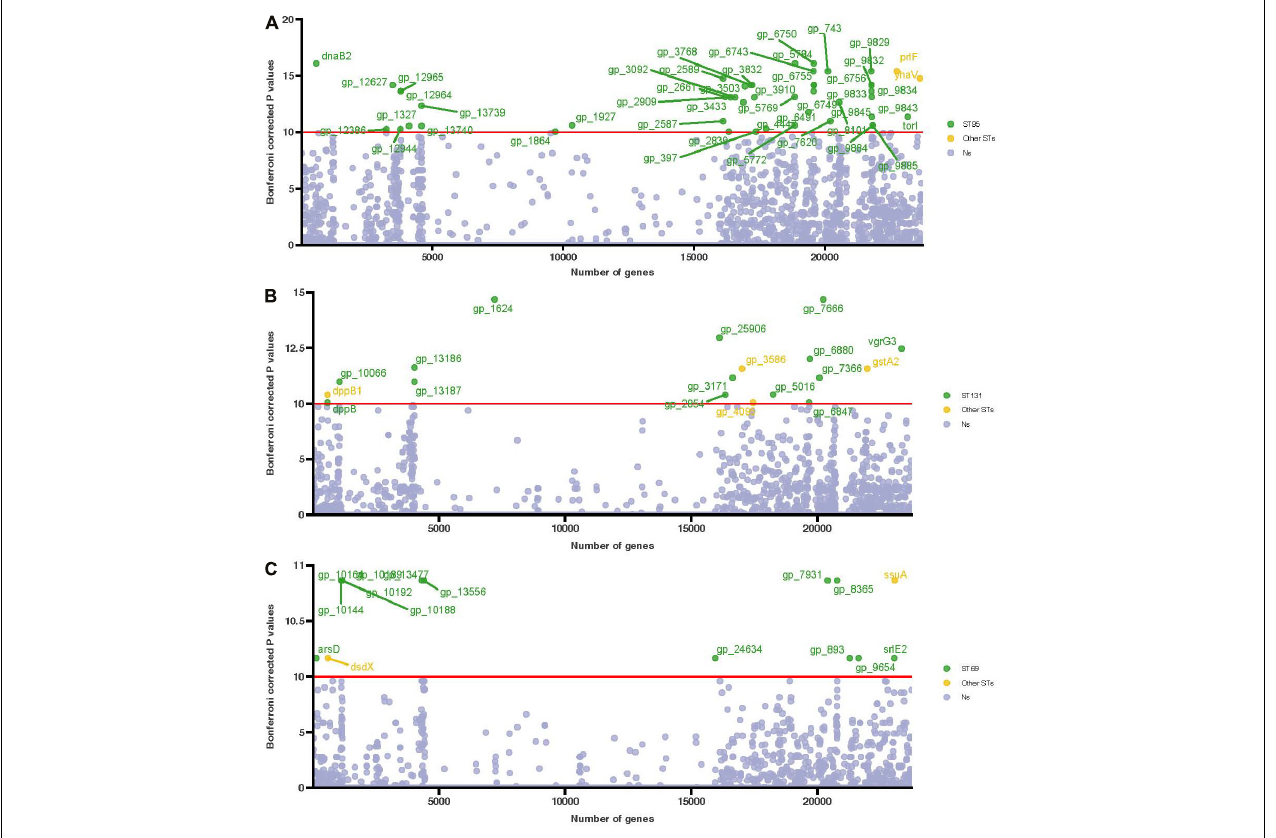
FIGURE 5 | Manhattan plot of the association of genes in the three main STs (ST95, ST131, and ST69) based on genome-wide association analysis. (A) ST95 compared with other STs, (B) ST131 compared with other STs, and (C) ST69 compared with other STs. Association of genes with phenotypes was determined using the multiple Kruskal-Wallis test. Uncorrected P -values are shown, and the Bonferroni corrected P -values for significance are indicated by the red horizontal lines. Genes more abundant in these three STs are in green, and genes more abundant in other STs are in